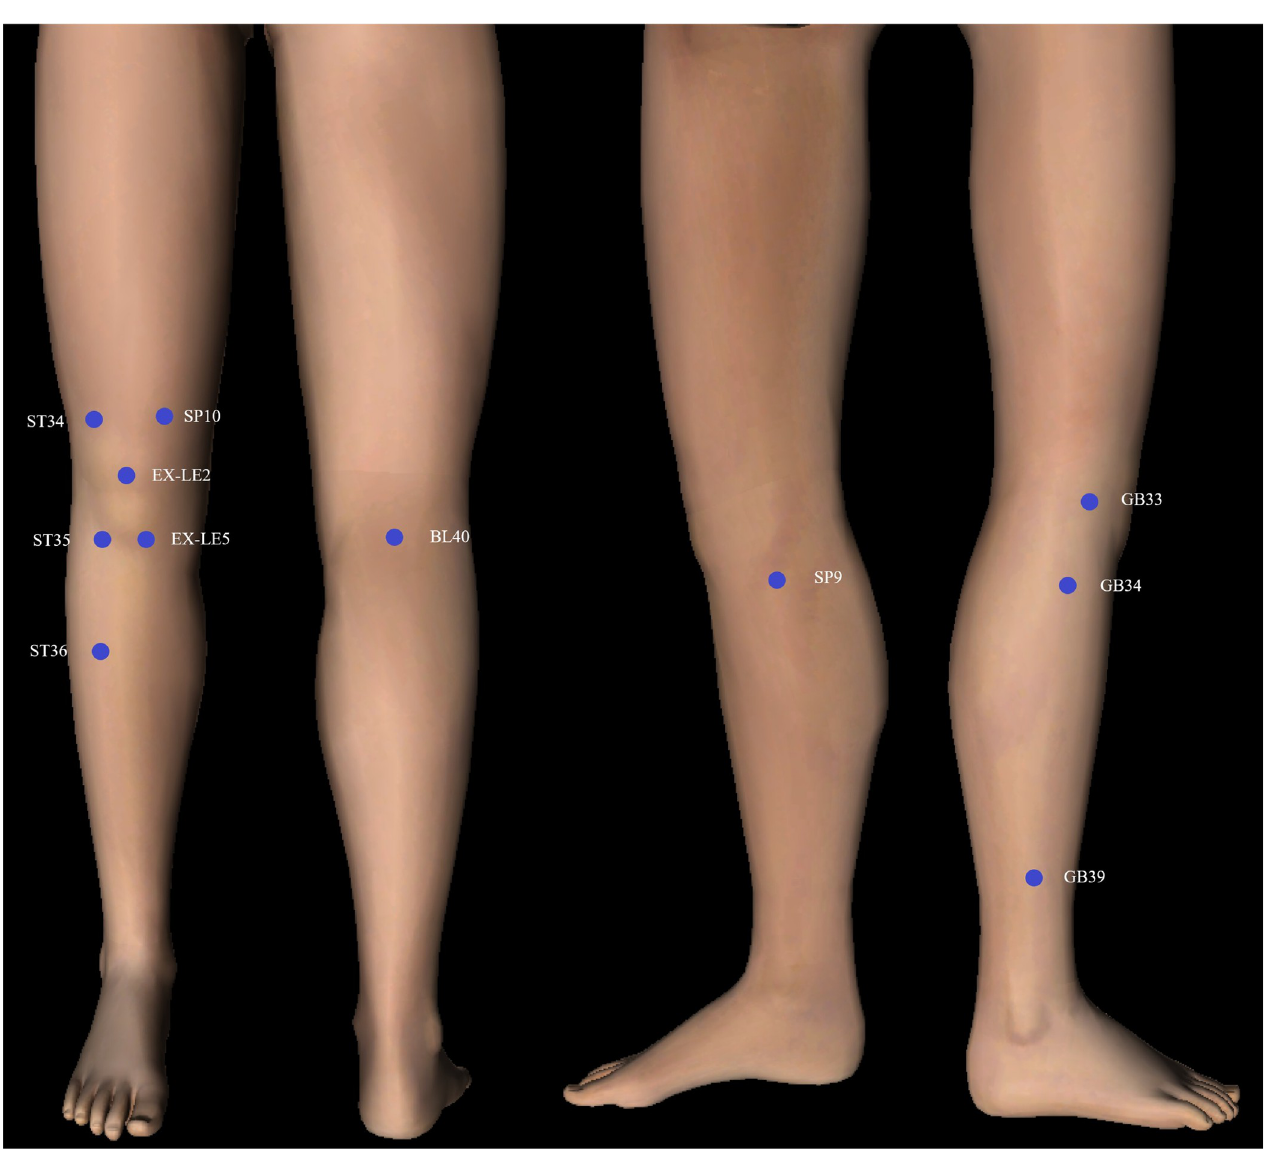
PLOS ONE | https://doi.org/10.1371/journal.pone.0284381 April 14,